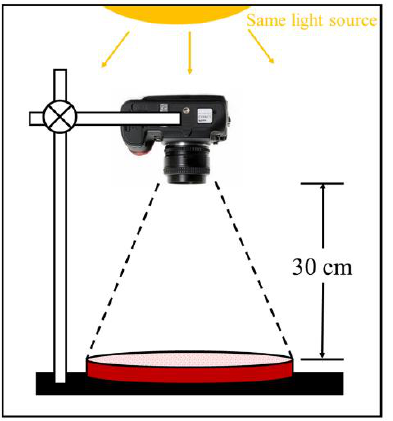
Figure 2. The schematic diagram of image acquisition device.